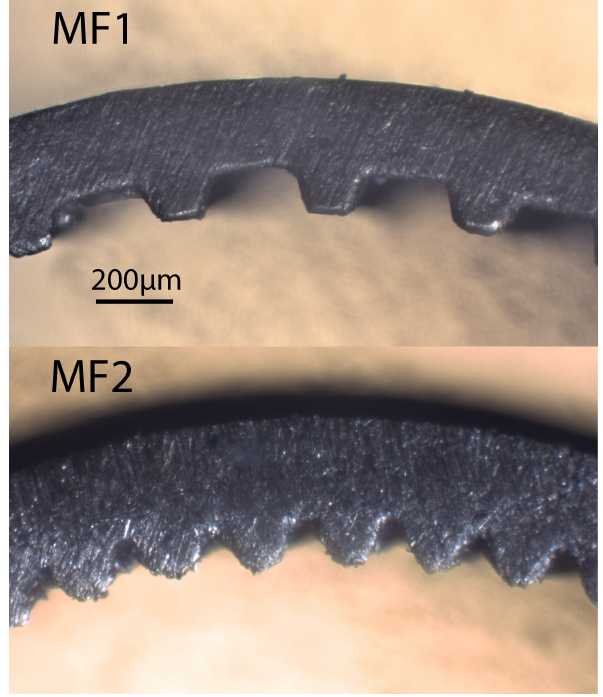
Figure 5. Cross sectional view of the microfinned tubes.